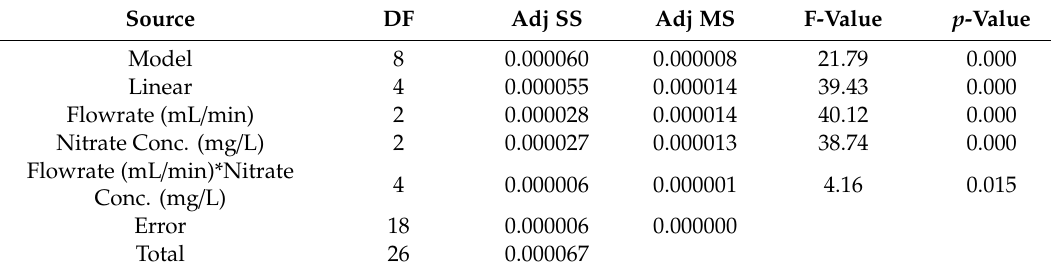
Table 4. Analysis of variance (ANOVA) for NO 3 − removal.